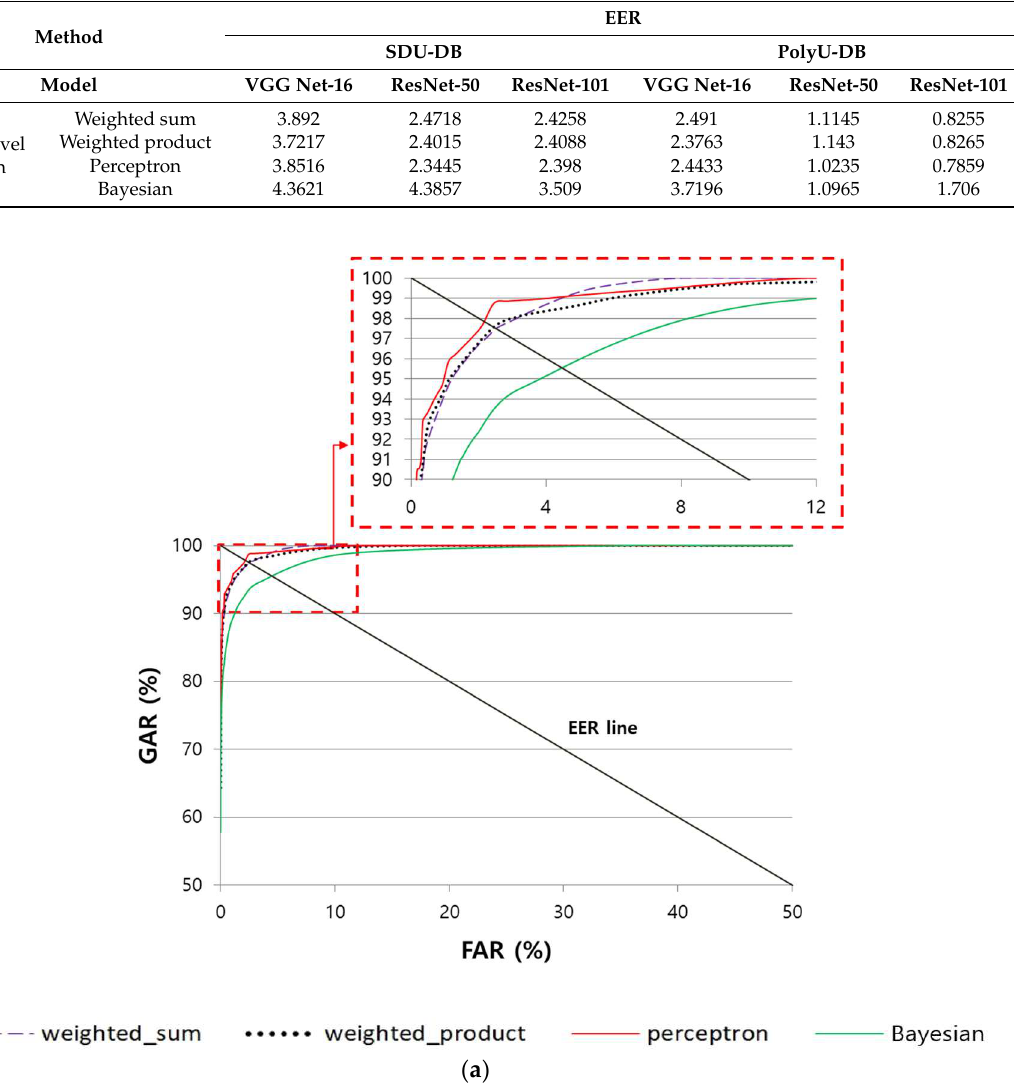
Table 8. Comparison of the accuracy of multimodal recognition according to various score-level fusion methods (unit: %).